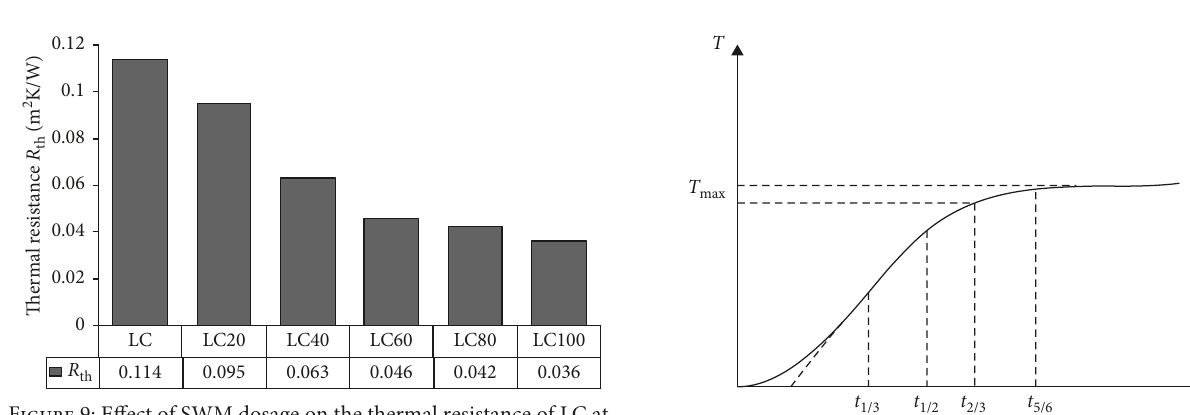
Figure 9: Effect of SWM dosage on the thermal resistance of LC at 28days. Figure 10: Schematic diagram representing partial times [30].